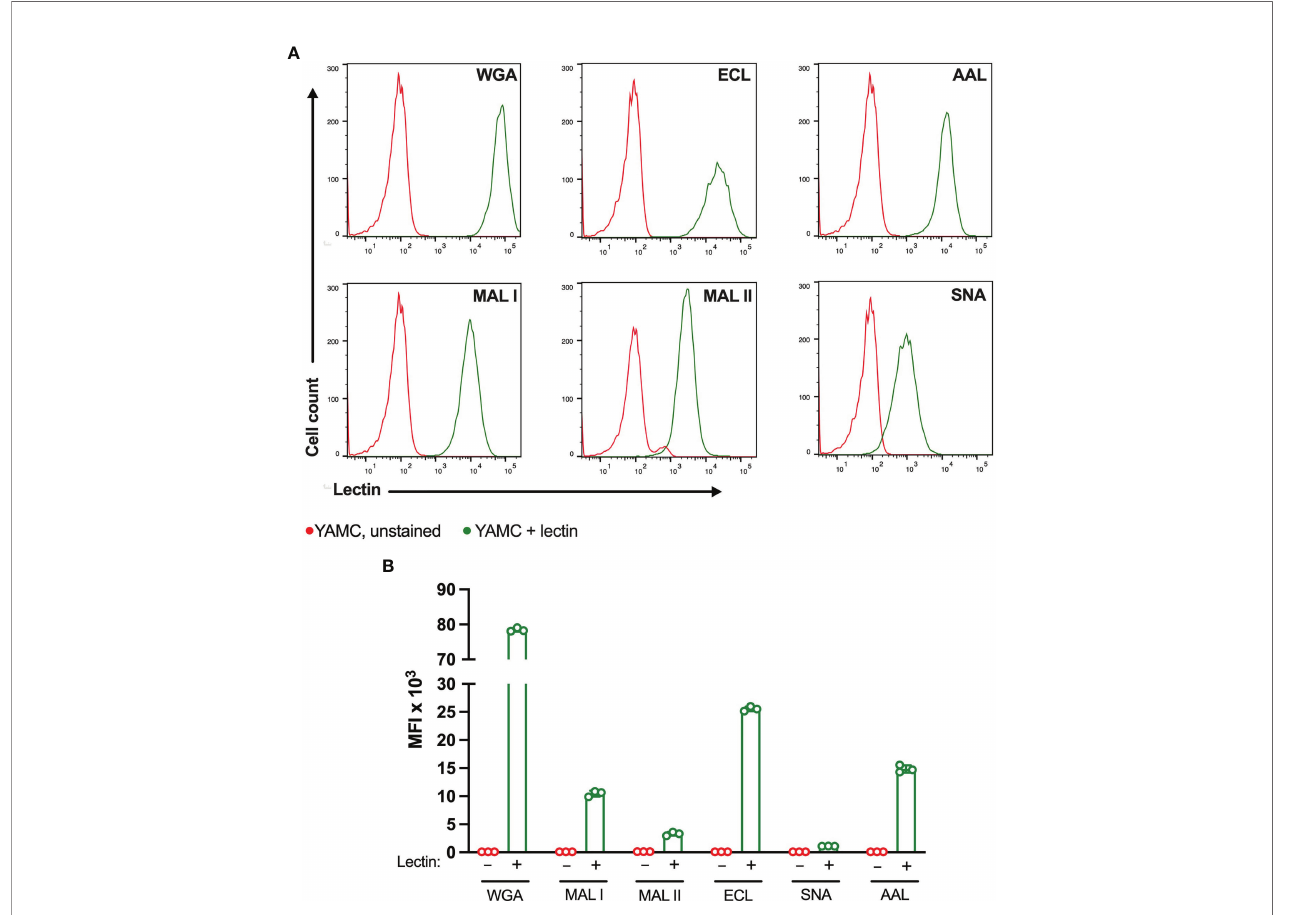
FIGURE 6 | Binding of plant lectins to non-transformed YAMC cells. (A, B) Binding ability of lectins used in the study to YAMC cells measured by fl ow cytometry. Unstained YAMC (red lines), stained YAMC (green lines). Each lectin was used at 10 m g/ml. Data are presented as mean and standard deviation of three